Question: What form of chart is displayed?
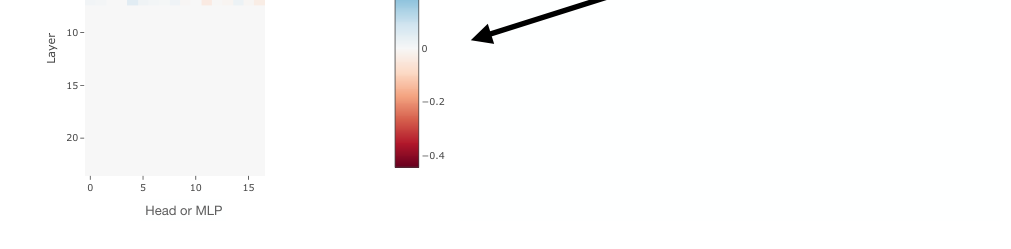
Answer: heatmap